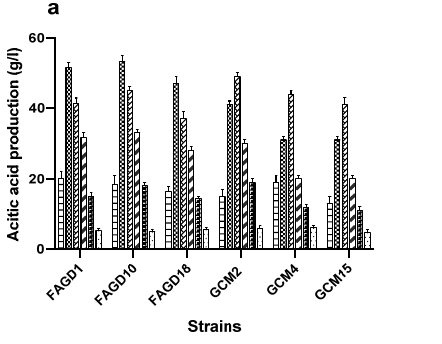
Figure 4. Effect of initial ethanol concentration on acetic acid production ( a ) and bacterial growth ( b